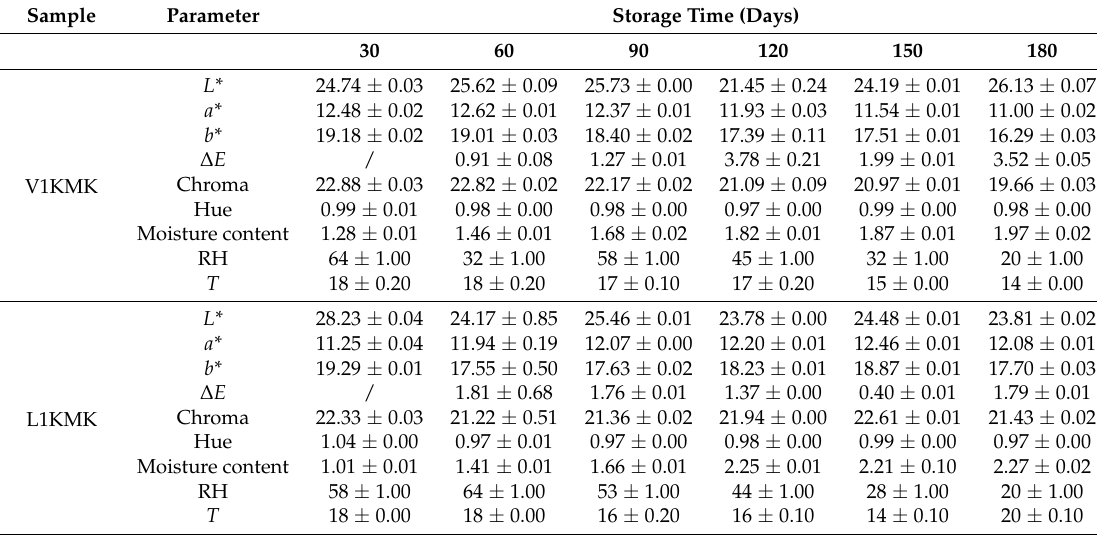
Table 1. Color components of roasted ground coffee samples during 6 months of storage. Results are shown as average ±